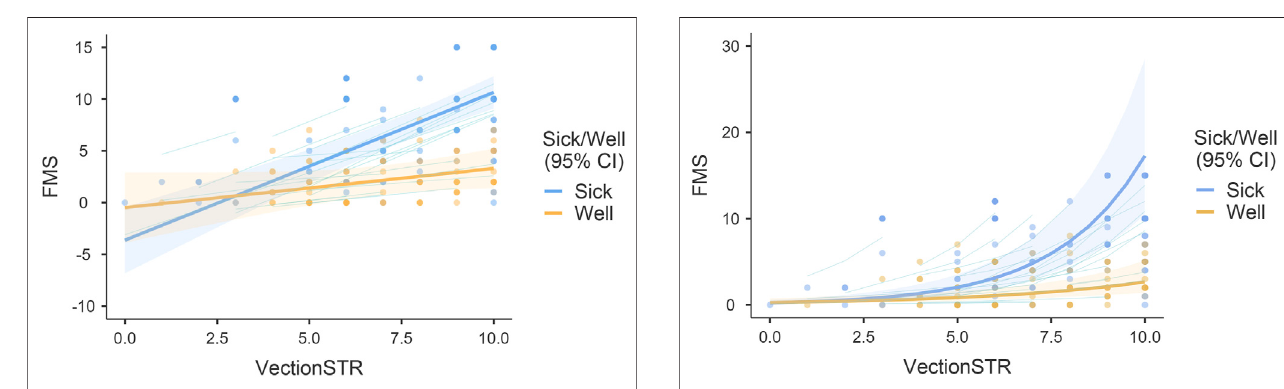
FIGURE 5 | Modelled linear relationships between vection strength (VectionSTR) and cybersickness severity (FMS) for the “ sick ” and “ well ” groups.